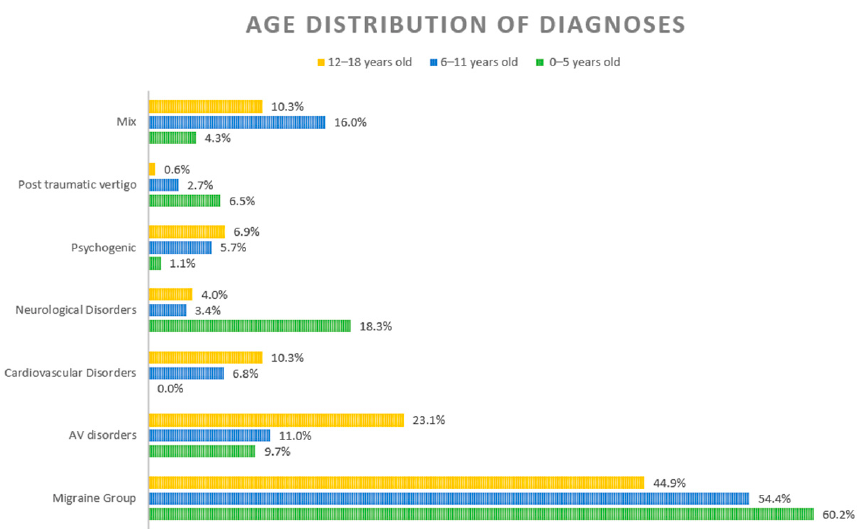
Figure 1. Distribution of different diagnoses according to age. (Reprinted with permission from Fancello et al. [1]).